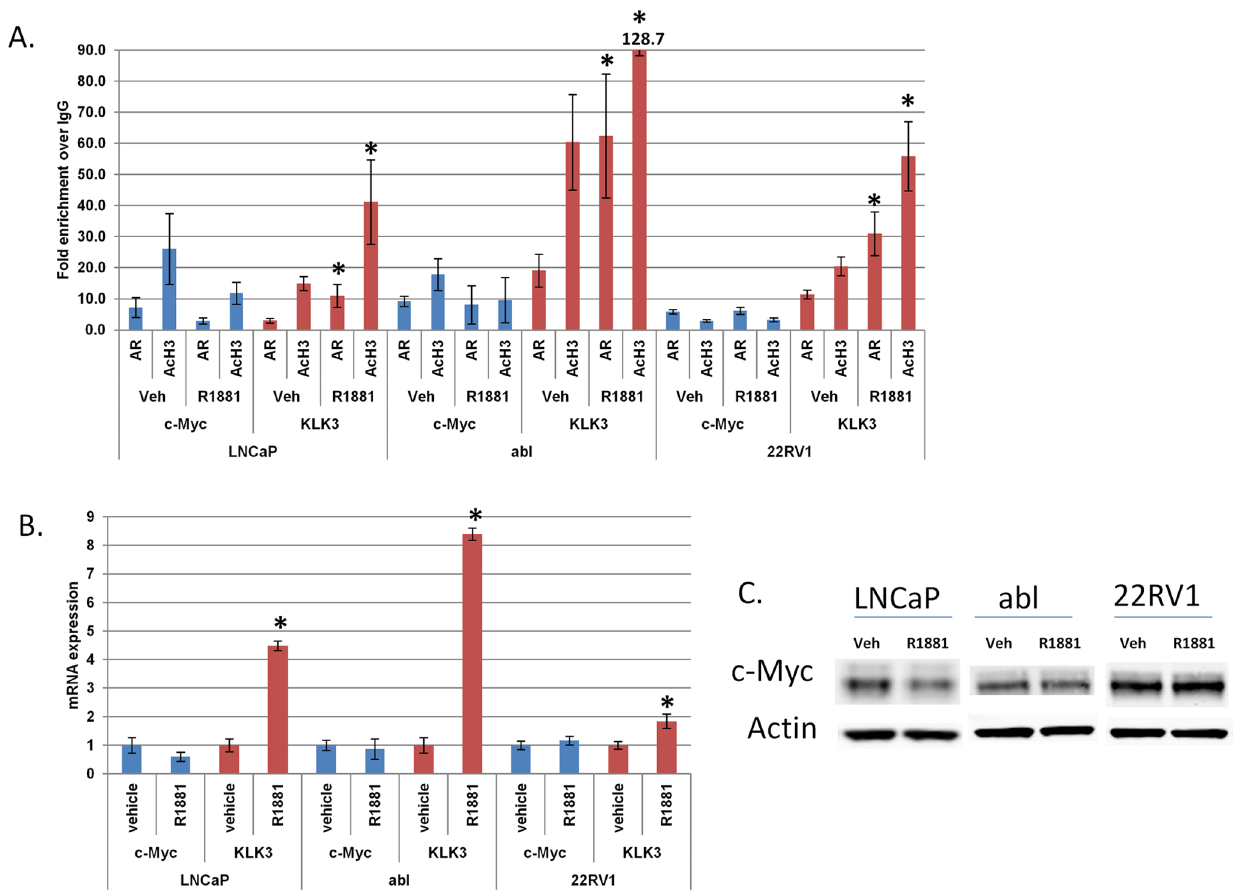
Figure 3. c-Myc expression is not activated by androgen ligands. LNCaP, abl, and 22RV1 cells were grown in charcoal-stripped serum for 72 hours and then treated with 10 nM R1881 (or ethanol vehicle) for 4 hours. A) Chromatin immunoprecipitation was performed to determine the enrichment of AR and histone H3 acetylation (AcH3) at the c-Myc and KLK3 enhancer elements. B) QRT-PCR was performed to determine the mRNA levels of KLK3 and c-Myc relative to actin. C) Immunoblotting was performed to determine the protein levels of AR, c-Myc, and actin. *denotes p , 0.05 compared to vehicle.